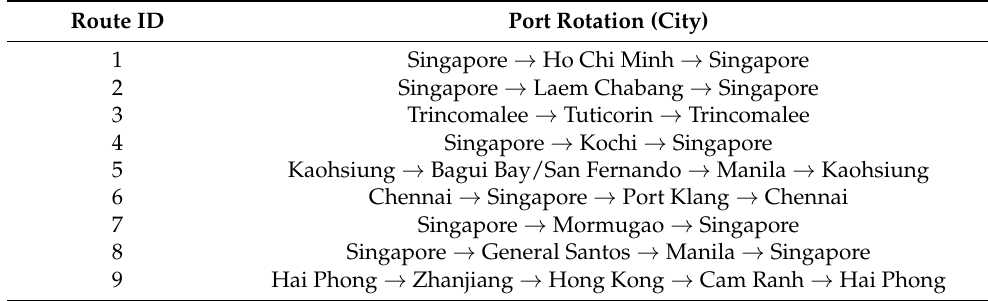
Table 2. Summary of ten